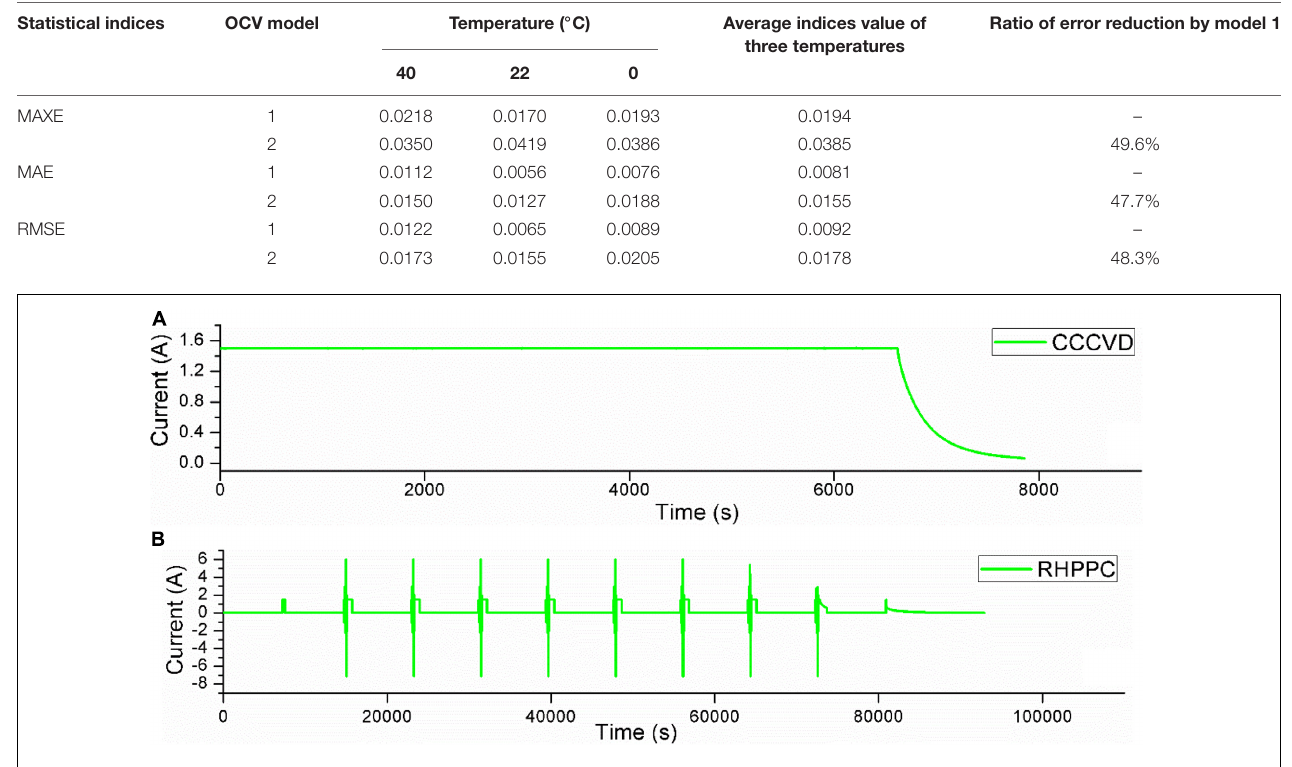
FIGURE 10 | Charging current profiles. (A) CCCVD; (B)